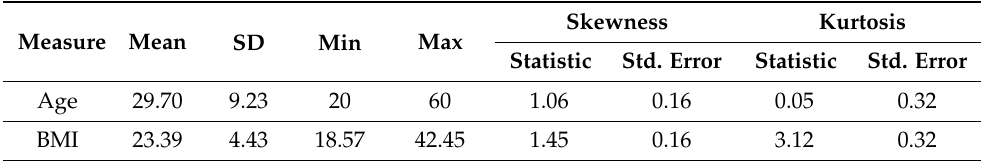
Table 1. Mean, standard deviation, minimum, maximum, skewness, and kurtosis values of age and body mass index for adult women (N =